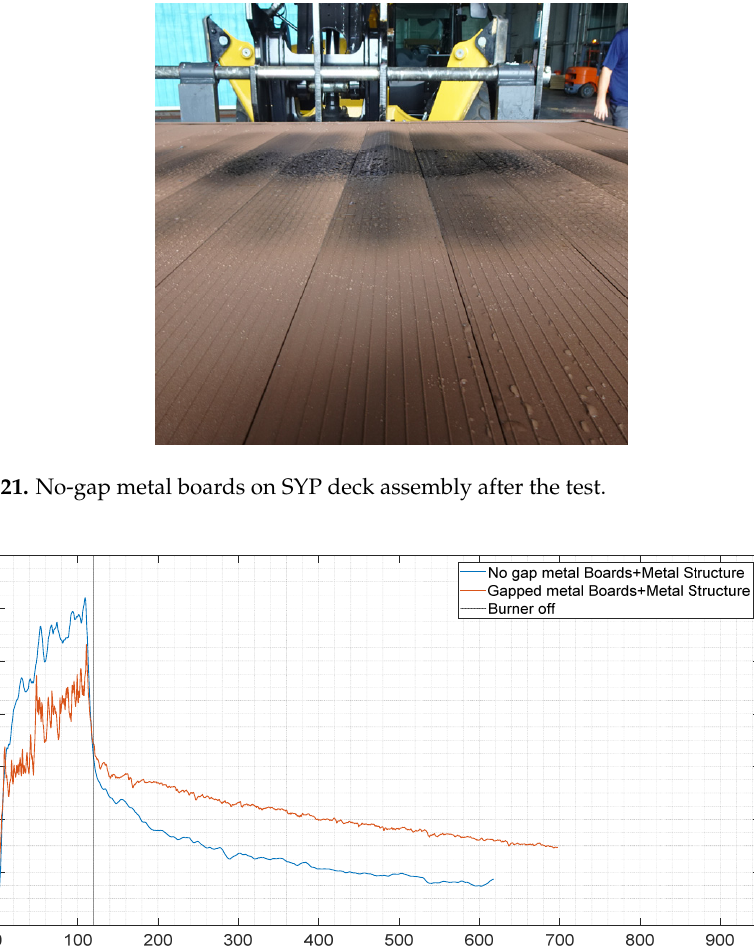
Figure 22. Wall temperature for gapped and no-gap metal boards over a metal substructure.